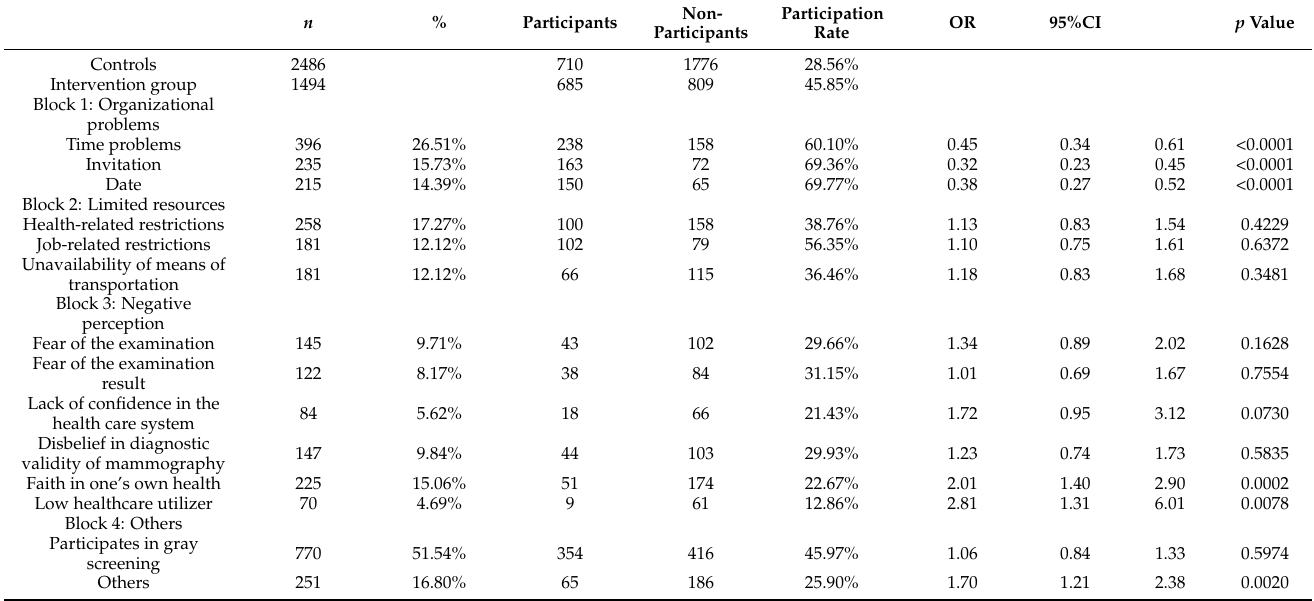
Table 1. Reasons for